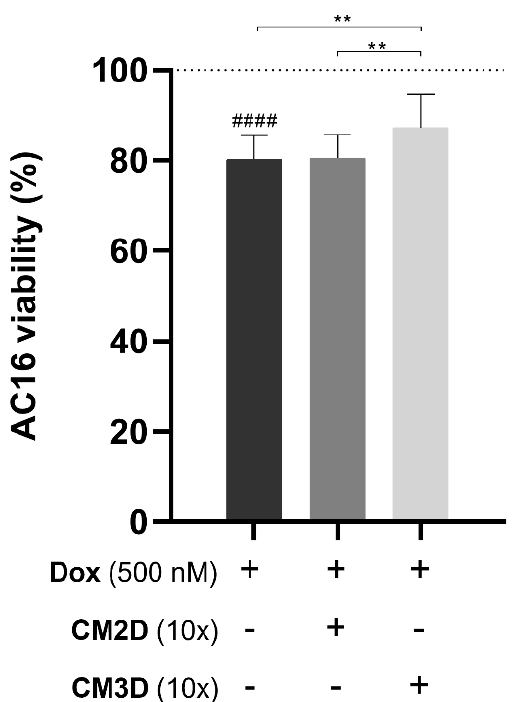
Figure 6. Exposure of AC16 cardiomyocyte cells to CM3D increased the viability of cells exposed to Dox. The differentiated AC16 cells were incubated with 500 nM of Dox alone or in combination with CM2D or CM3D being the cytotoxicity evaluated by MTS reduction assay. Cell viability is expressed in percentage (mean ± SD, n = 3–6) to non-treated differentiated AC16 cells (control). Grid line represents 100% cell viability (control). Statistical significance is expressed relative to Dox as ** p < 0.01 and to control of non-treated cells, i.e., 100% viability as #### p < 0.0001. CM2D, conditioned medium derived from 2D cultures; CM3D, conditioned medium derived from 3D cultures; Dox,